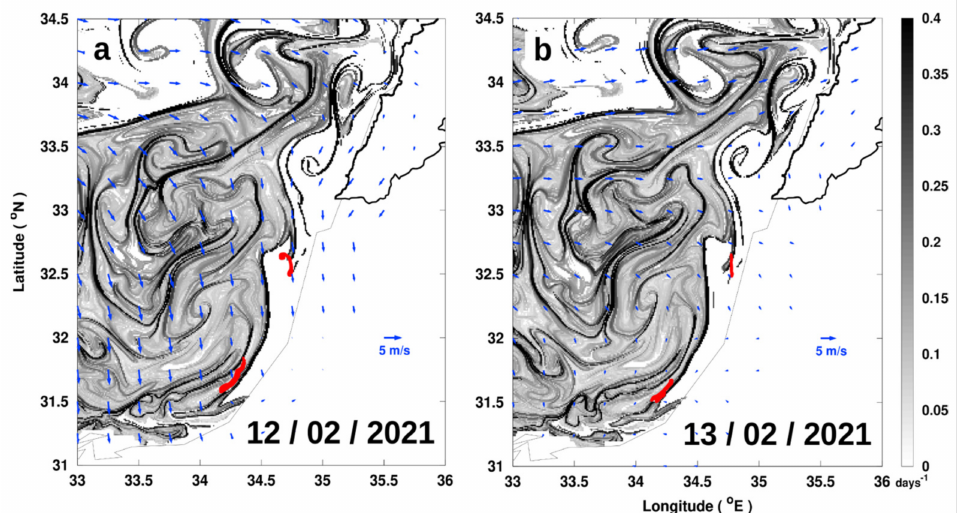
Figure 11. FSLE maps using surface currents corrected with a wind component for the 12th and 13th of February 2021 in panels ( a , b ), respectively. The red patterns in panels ( a , b ) represent the position of the oil slicks. Wind speed is represented as blue vectors in both